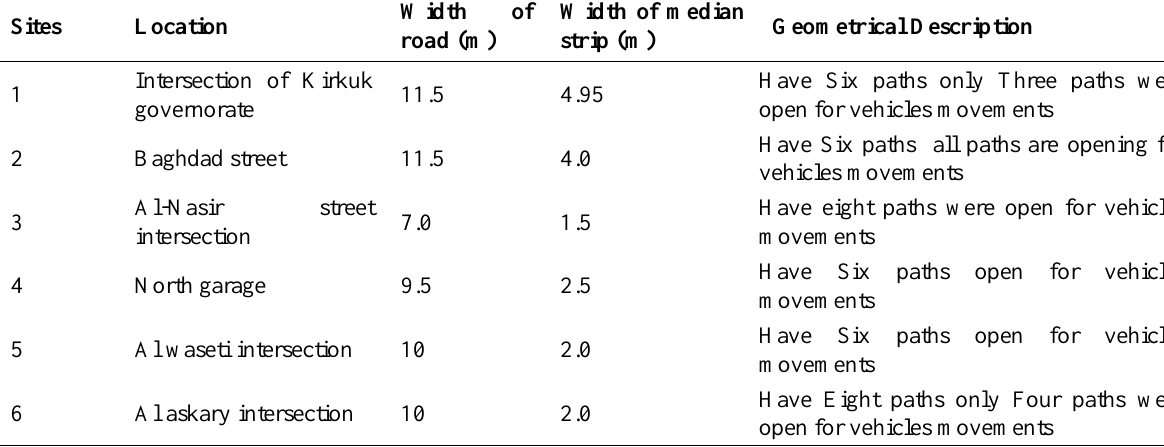
Details of the selected study sites in Kirkuk city Location Sites